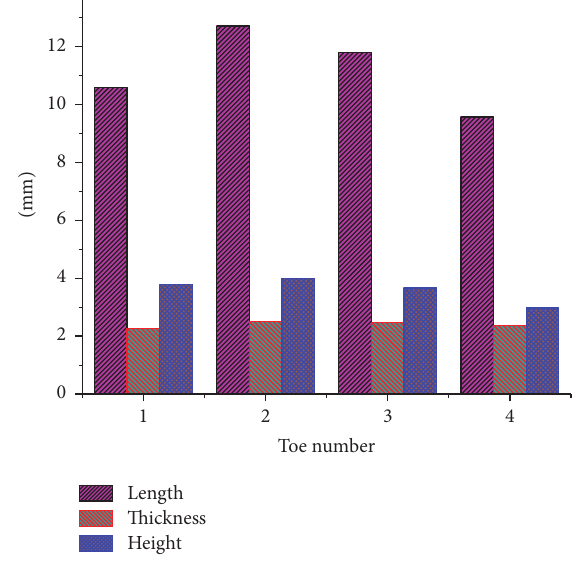
Figure 2: The measurements of each toe.